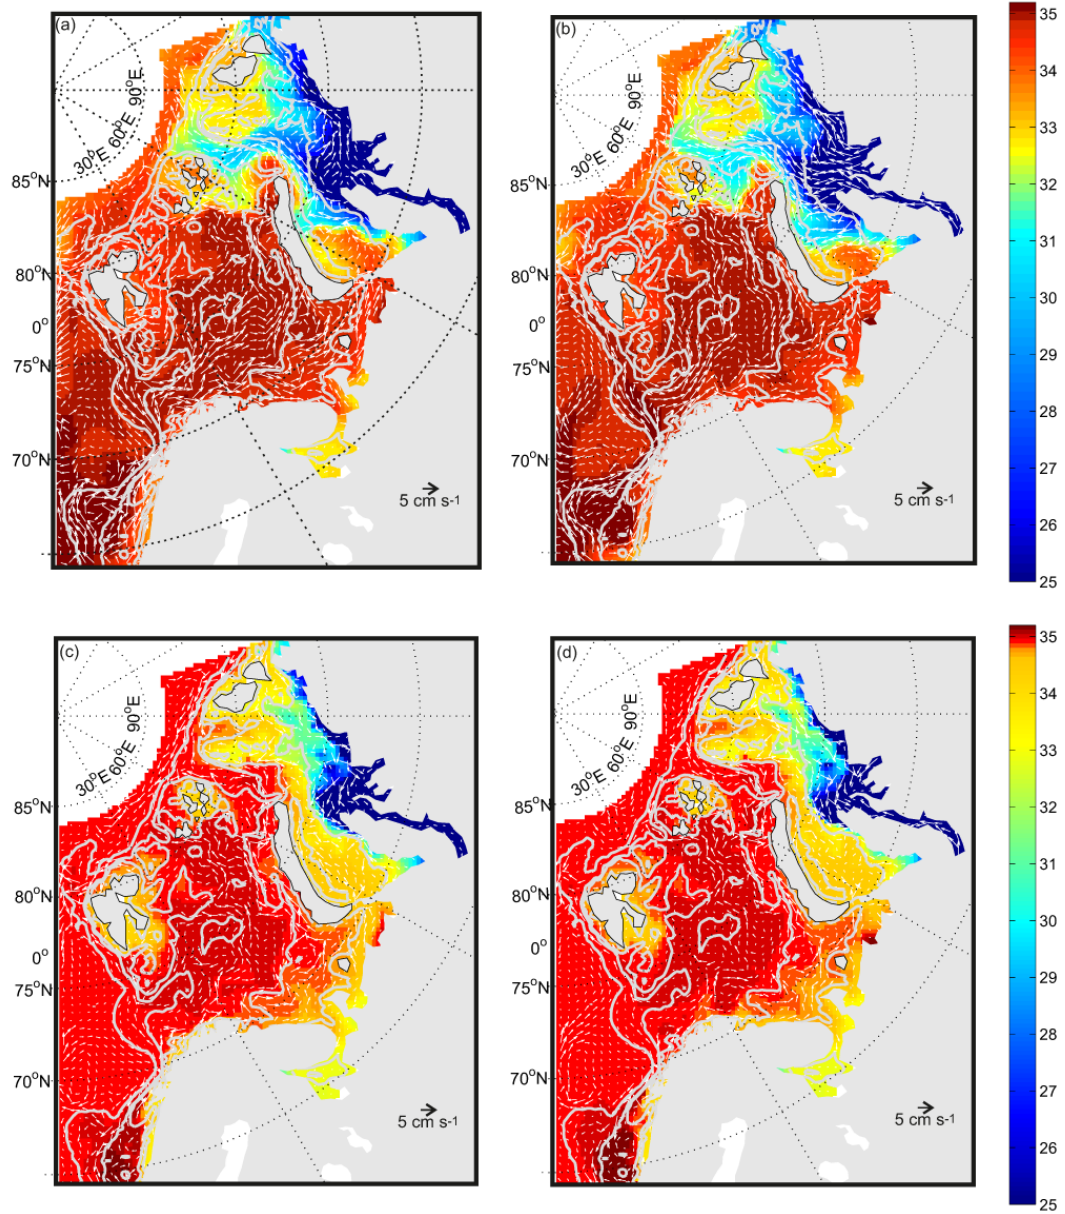
Fig. 7. Mean sea surface salinity (color contours) and velocity (arrows) for (a) winter and (b) summer from the fifth year of integration of the control model run (without tides). Mean sea bottom salinity (color contours) and velocity (arrows) for (c) winter and (d) summer from the fifth year of integration of the control model run (without tides). 50m, 200m 400m and 1000m bathymetric contours are shown. Winter is defined as December, January, February and summer is defined as June, July, and August. For clarity, the velocity vectors are capped at 5cms − 1